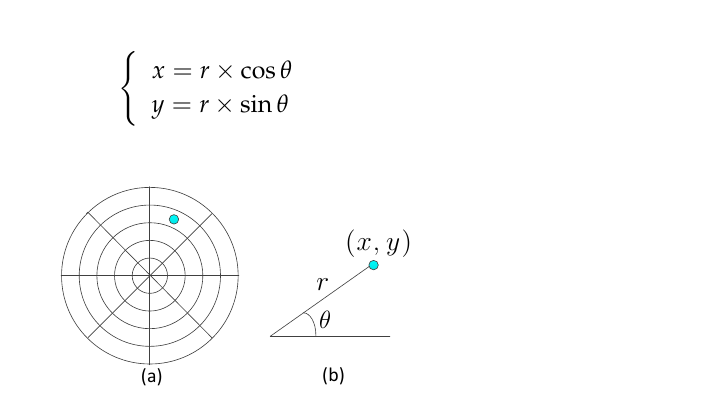
Figure 5. ( a ) The floor projection of the sampling cells; the segmentation of the monitored space within one sensor node. ( b ) The center of the cell; the blue point is denoted by polar